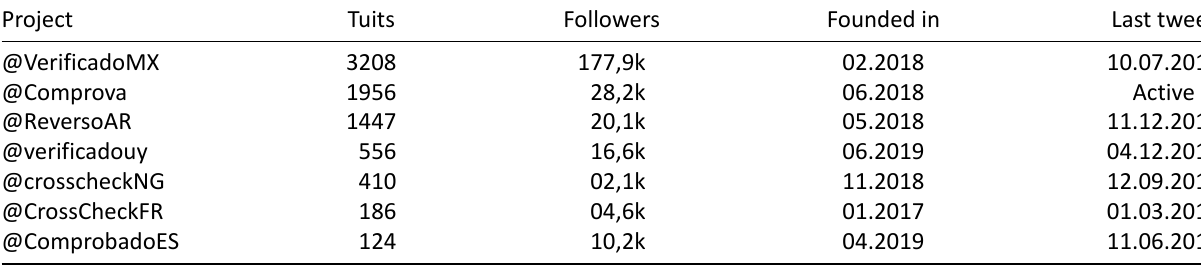
Table 3. Cross-checking projects on